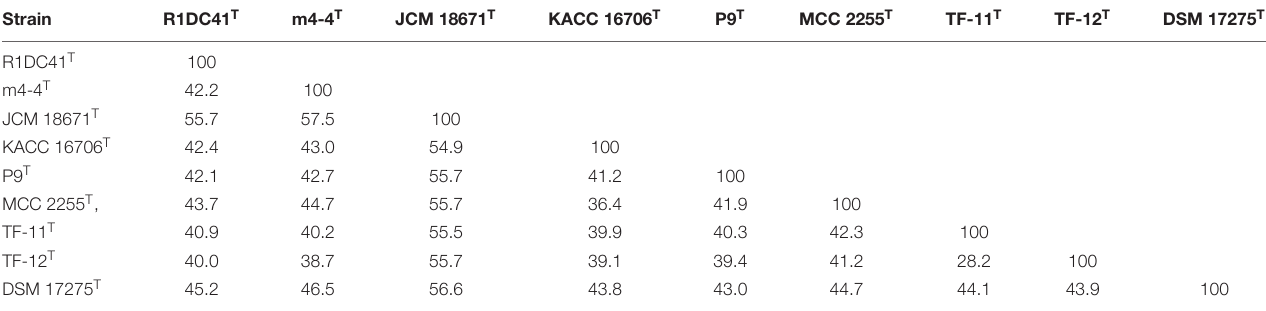
TABLE 2 | Average Amino Acid Identity (AAI) of R1DC41 T strains in comparison with other closely related species belonging to the Bacillaceae , Lactobacillaceae , and Planococcaceae . Strain R1DC41 T m4-4 T